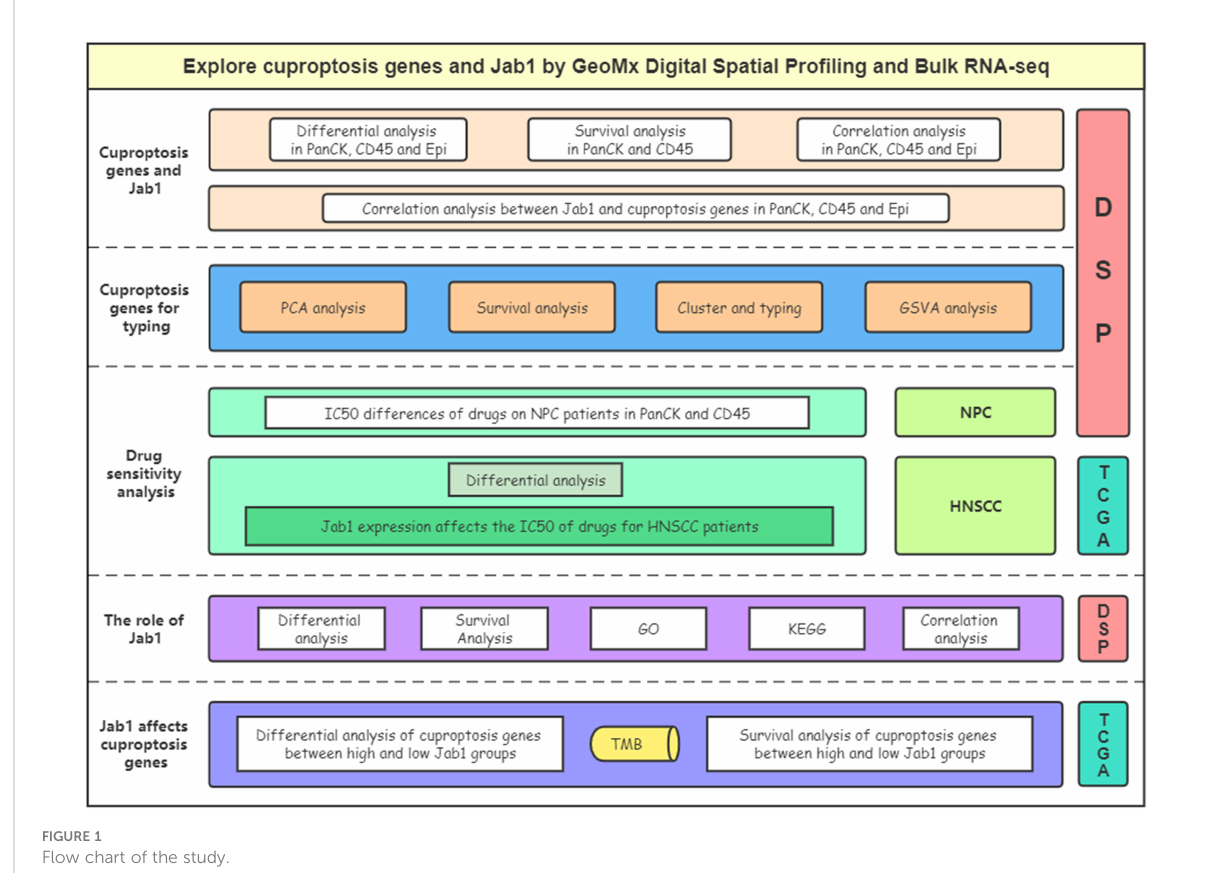
FIGURE 1 Flow chart of the